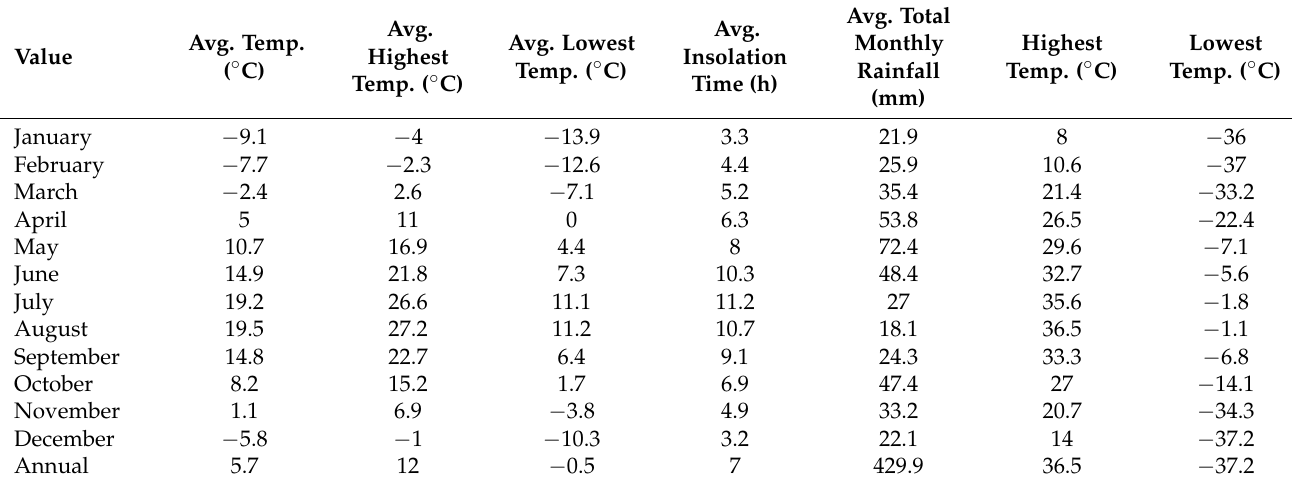
Table 2. Meteorological data for Erzurum (1929–2021).